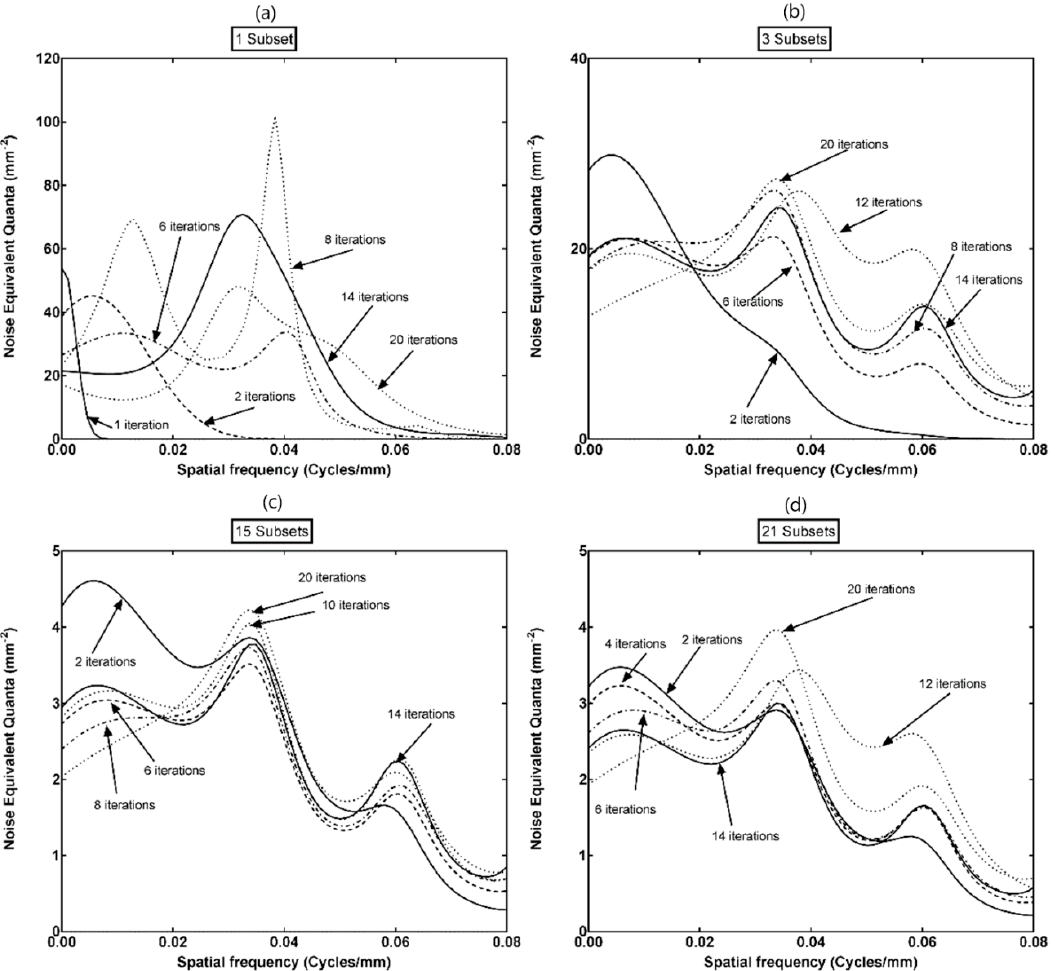
Figure 1. ( a ) Noise-equivalent quanta from the plane source, obtained using OS-MAP-OSL, one subset combined with 1, 2, 6, 8, 14 and 20 iterations, ( b ) three subsets combined with 2, 6, 8, 12, 14 and 20 iterations, ( c ) 15 subsets combined with 2, 6, 8, 10, 14 and 20 iterations, and ( d ) 21 subsets combined with 2, 4, 6, 12, 14 and 20 iterations.